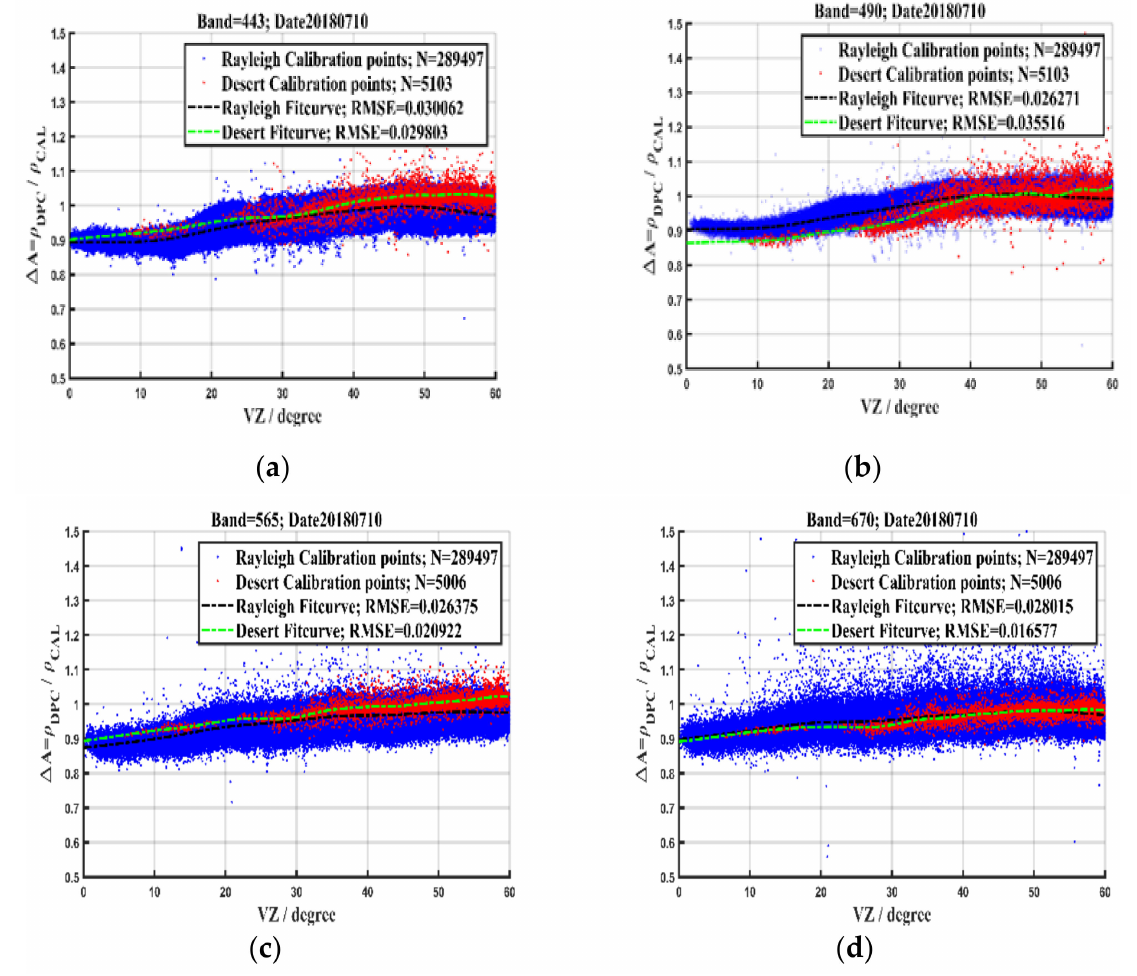
Figure 7. The radiometric deviation calculated by using desert sites and ocean sites in the VIS bands of the DPC: ( a ) Band 443; ( b ) Band 490; ( c ) Band 565; ( d ) Band 670. Table 4. The deviation factor of the DPC calibrated by the SNES and LNES at different view zenith angles.